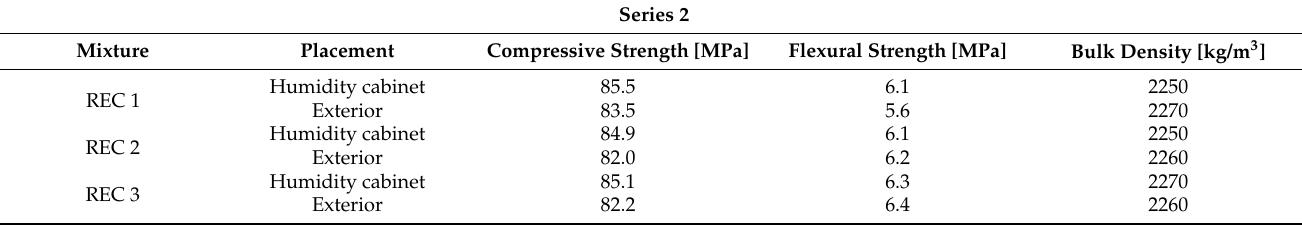
Table 6. Results of basic physical and mechanical properties for Series 2.